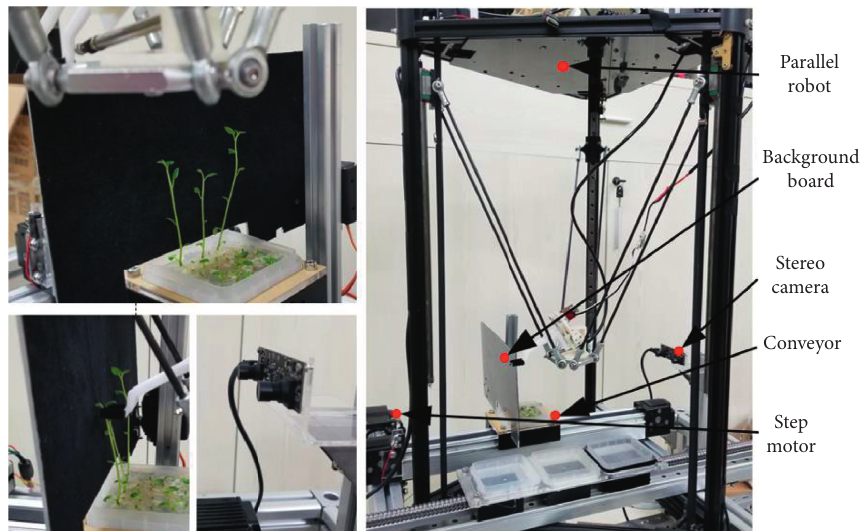
Figure 1: Diagram of the robot system structure.